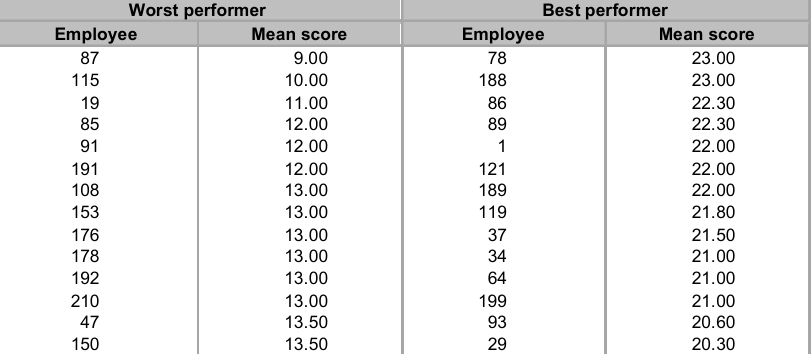
Worst performer Best performer